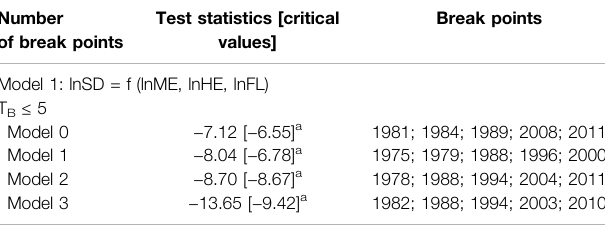
TABLE 5 | Maki (2012) Cointegration test under multiple structural breaks.